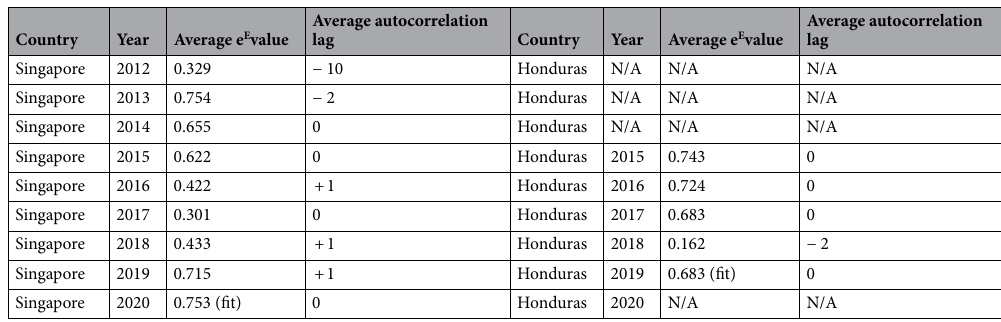
Table 7. Statistical results for the climate model. "Average" represents the average correlation value for the five displayed simulations. “Fit” represents the outbreak year the model was fit to. N/A not applicable.